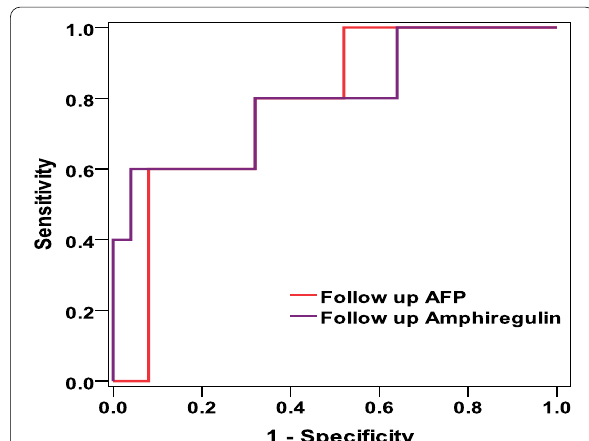
Fig. 3 ROC curve for follow-up AFP and amphiregulin in diagnosing and predicting tumor